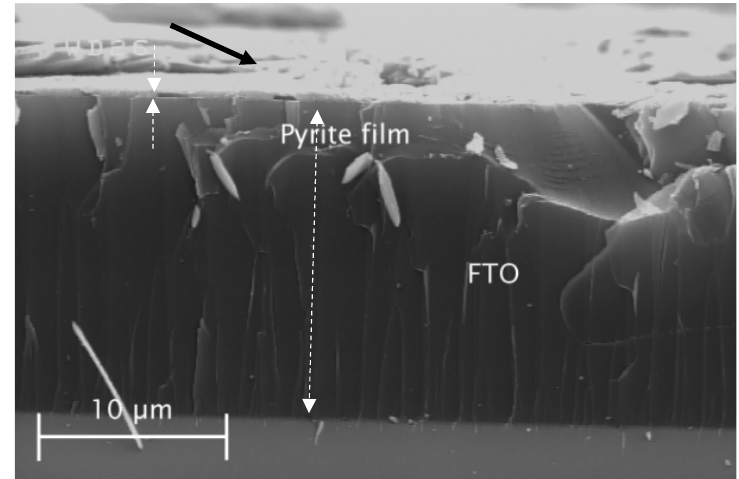
Figure 9 . Top FESEM image of the thin film sample after sulfurization (Sample G3).